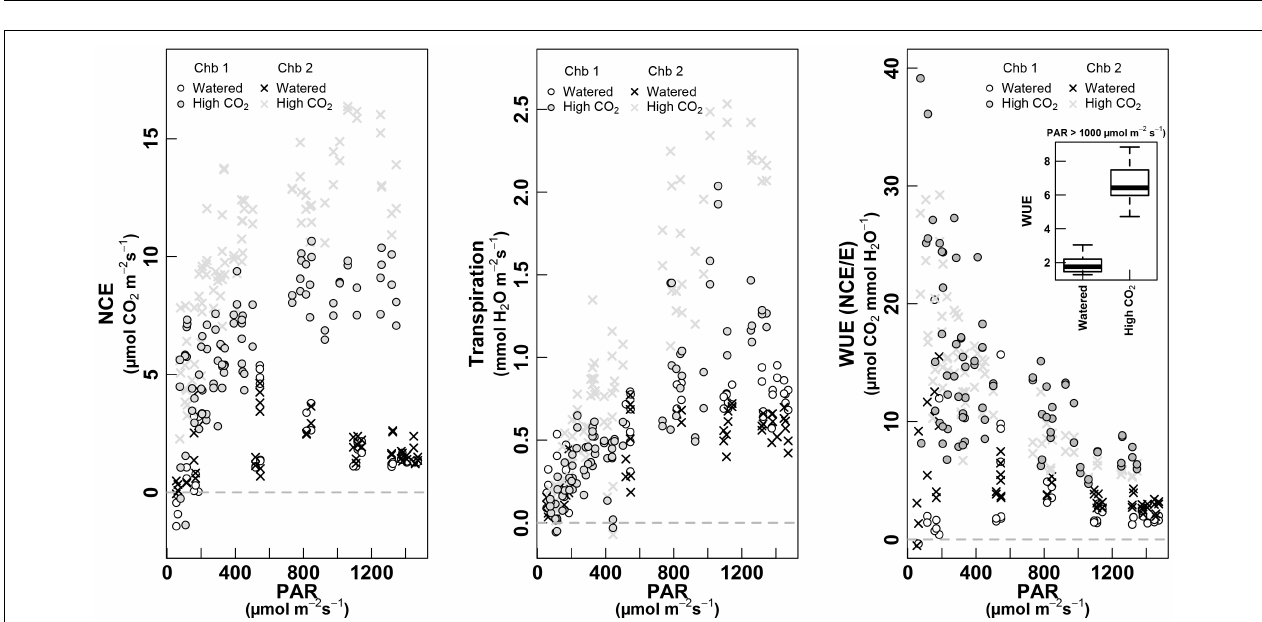
FIGURE 7 | Left panel: monitoring of the [CO 2 ] entering the chamber over cycles of 24 h. White dots denote the second “Watered” session (September 2017) for the chamber 1, and the black crosses for the chamber 2, both of them at ambient (atmospheric) CO 2 . Gray circles and gray crosses denote the “High CO 2 ” treatment (September 2017) for chambers 1 and 2, respectively. Right panel: calibration curves used to correct the estimated NCE during the “High CO 2 ” experiment. White dots are for the chamber 1, and gray dots for the chamber 2. Measurements where carried-out during the night to avoid photosynthetic processes to influence the measurements (and considering the night-respiration as negligible), then [CO 2 ] was increased by steps from 400 µ mol mol − 1 to approximately 900 µ mol mol − 1 in order to obtain a calibration curve. This curve was then subtracted to the row-data obtained under high CO 2 conditions.